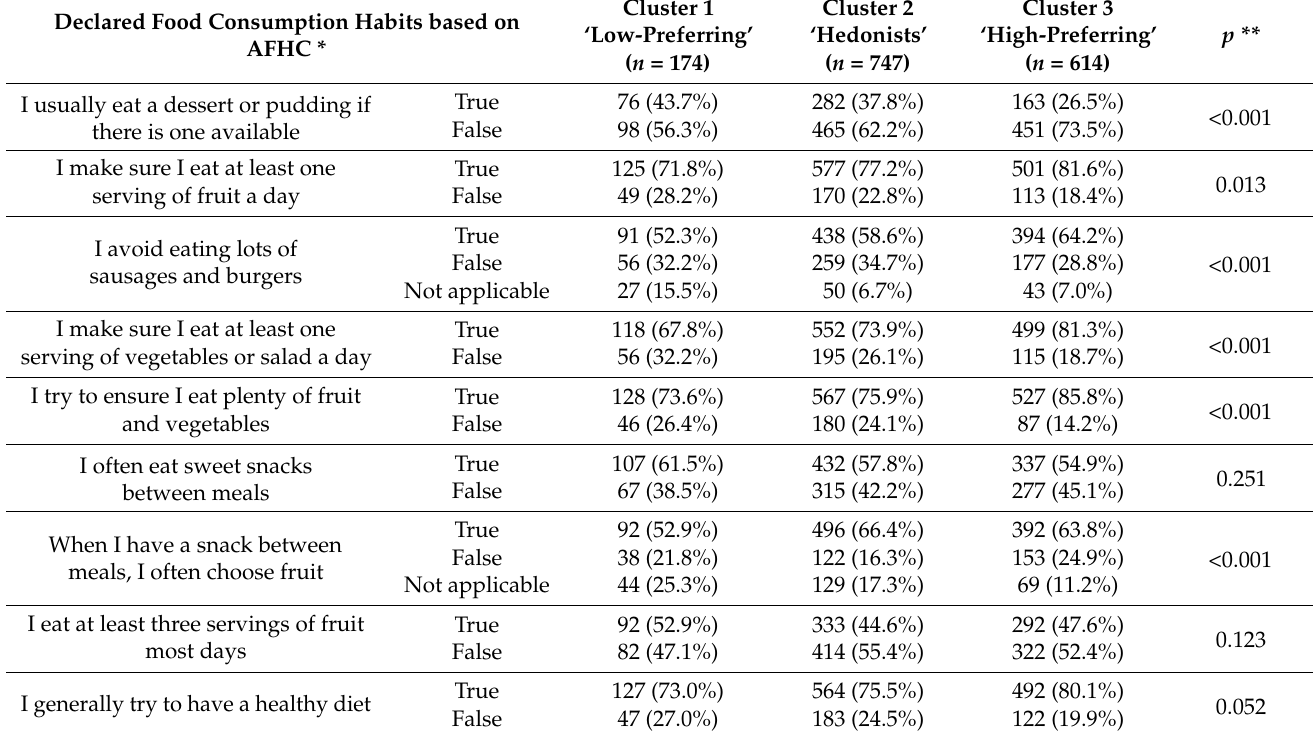
Table 8. The declared food consumption habits assessed based on the Adolescents’ Food Habits Checklist (AFHC) in the clusters stratified based on the preferences assessed while using the Food Preference Questionnaire (FPQ) within the female population of the second phase of the Polish Adolescents’ COVID-19 Experience (PLACE-19) Study ( n = 1535). Declared Food Consumption Habits based